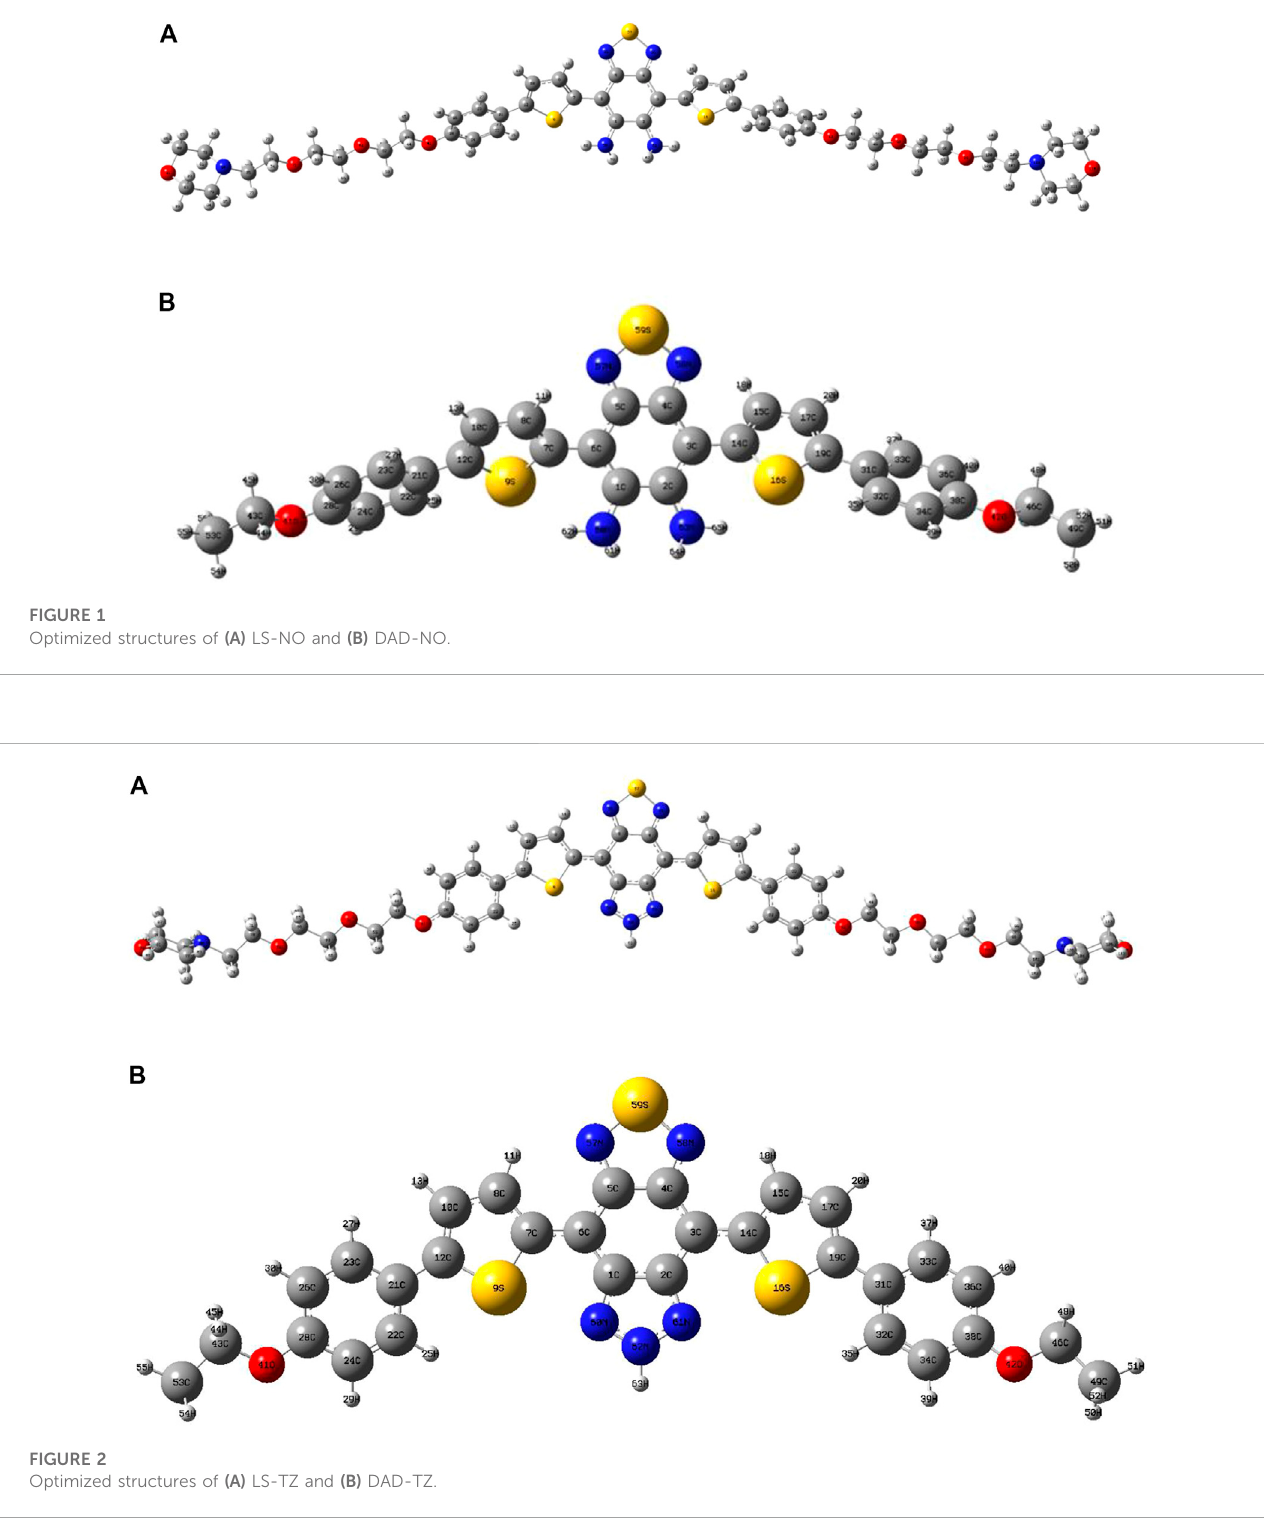
developed by Liu et al. (2021b). The probe used oligoglycol morpholine-functionalized thiophene as strong electron donors and diaminobenzene (1,2,5-thiadiazole) as a weak electron acceptor and NO trapping group. After the speci fi c reaction of the probe with NO, the weak electron acceptor group diaminobenzene (1,2,5-thiadiazole)